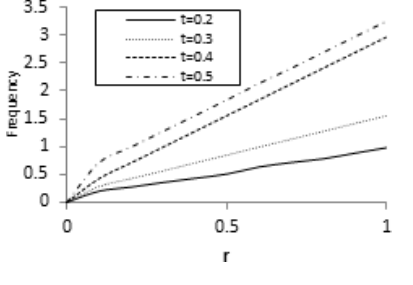
Figure 10: Distribution of frequency with the radius via RPL ℜ = 2